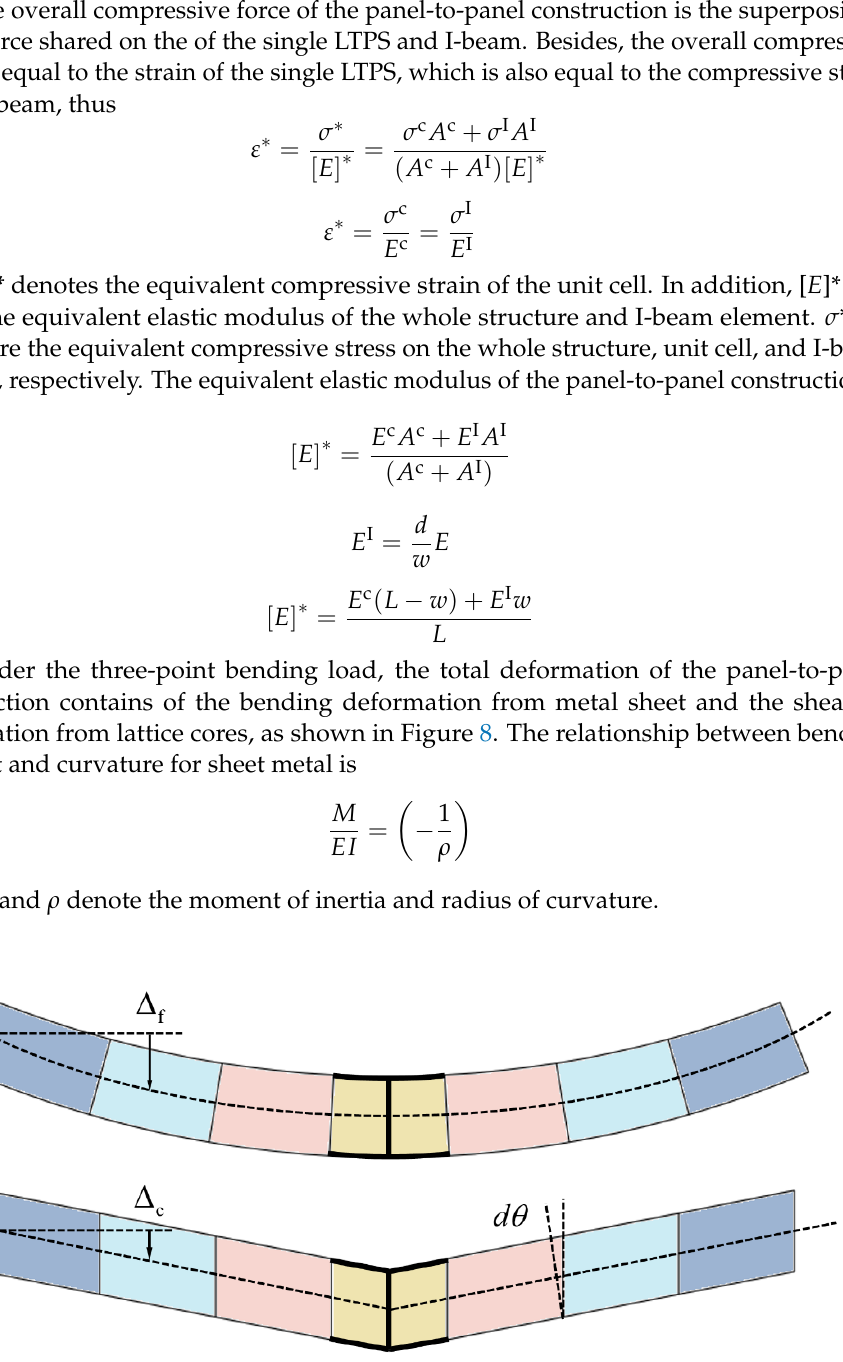
Figure 8. Deformation sketch of sheet metal ( a ) and lattice core ( b